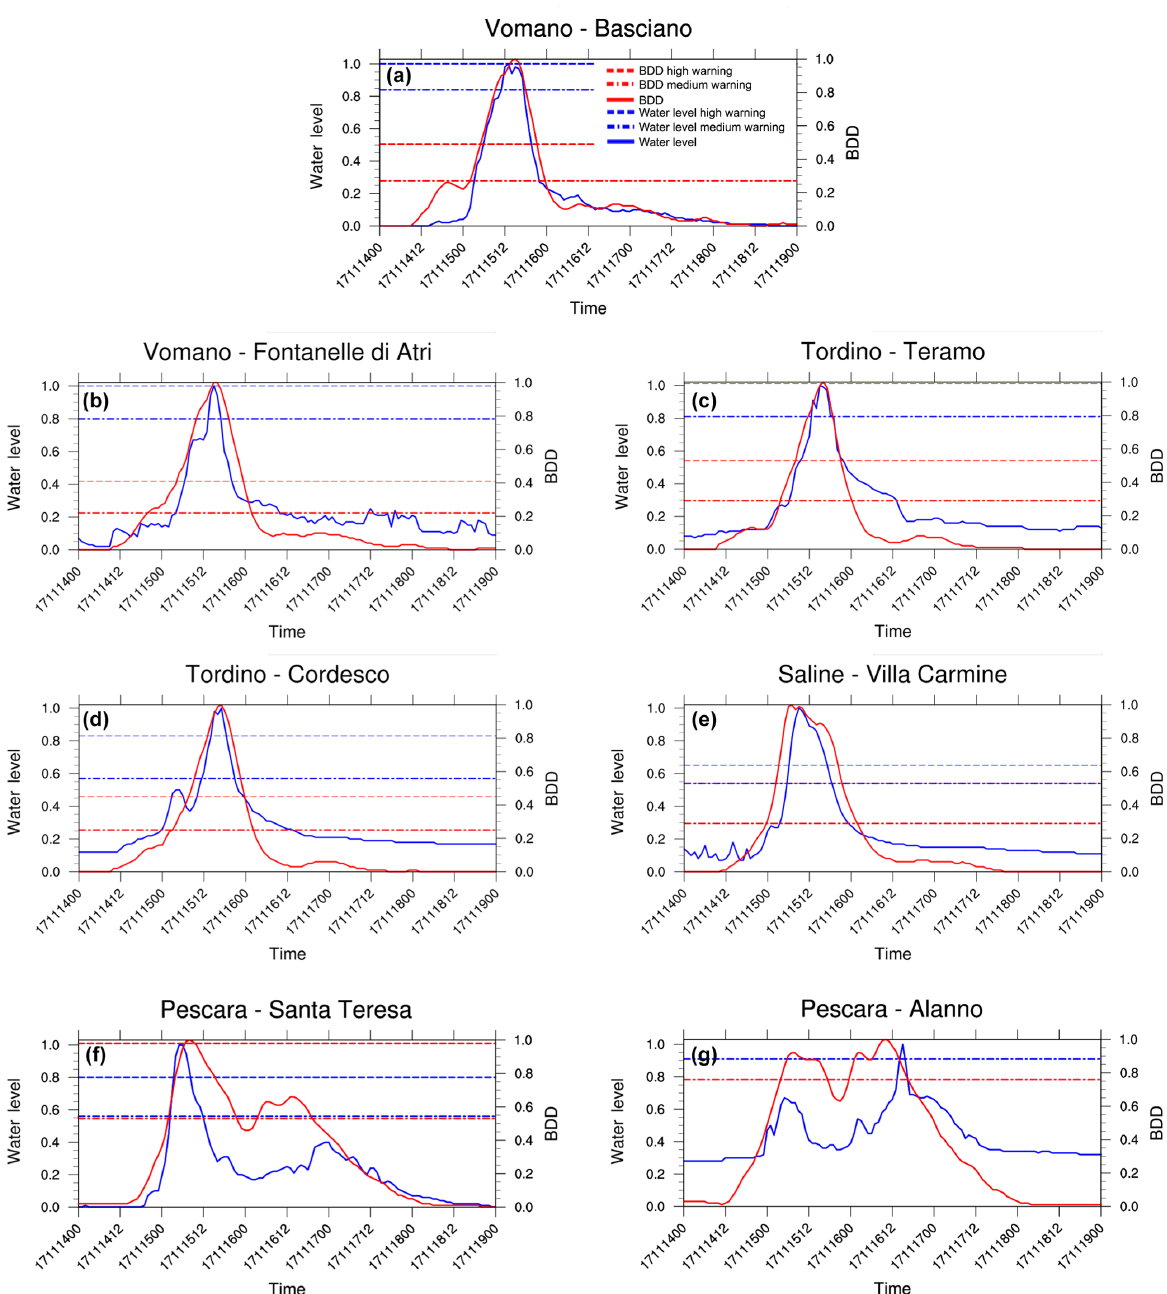
Figure 10. Normalized BDD time series (time given in the format of day, month, two-digit year and hour) and water level for the catch- ments of Vomano, Tordino, Saline and Pescara at stations (a) Basciano (Vomano), (b) Fontanelle di Atri (Vomano), (c) Teramo (Tordino), (d) Cordesco (Tordino), (e) Villa Carmine (Saline), (f) Santa Teresa (Pescara) and (g) Alanno (Pescara). The BDD index is represented by red lines, and the observed water level is represented by blue